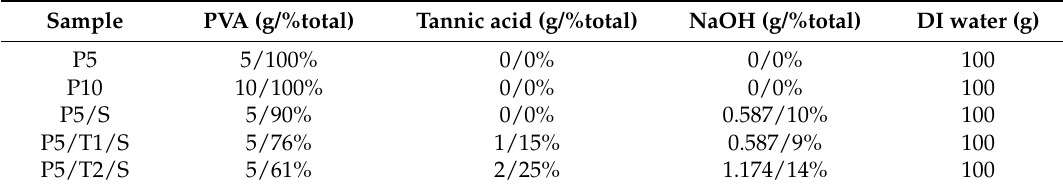
Table 1. Composition of